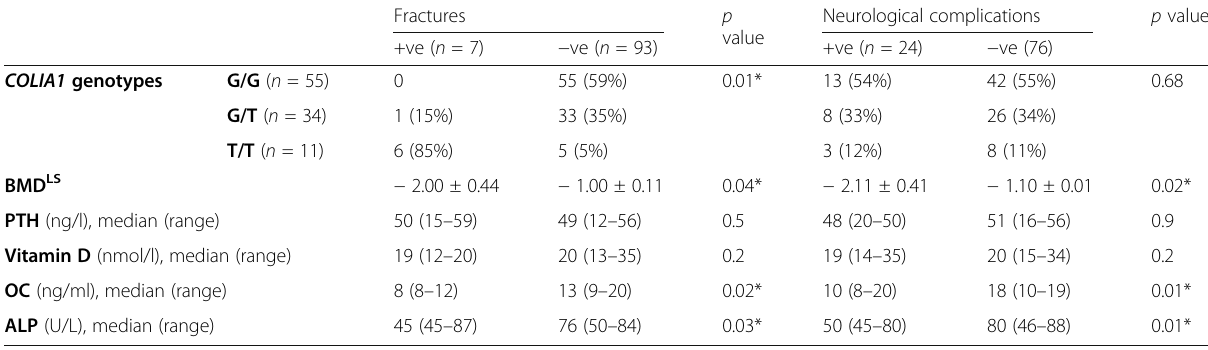
Table 4 Genetic and laboratory characteristics of the patients regarding the detection of fractures as well as neurological complications (during the second assessment)